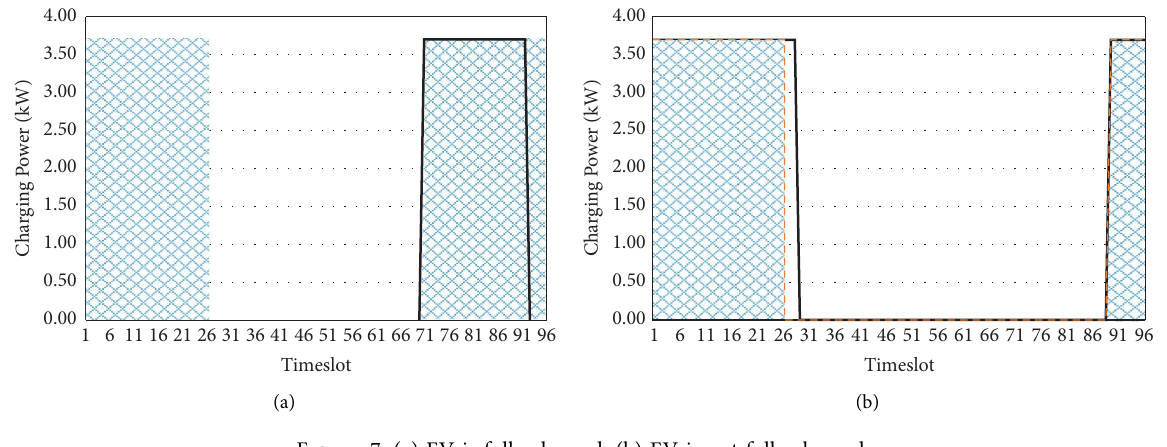
Figure 7: (a) EV is fully charged. (b) EV is not fully